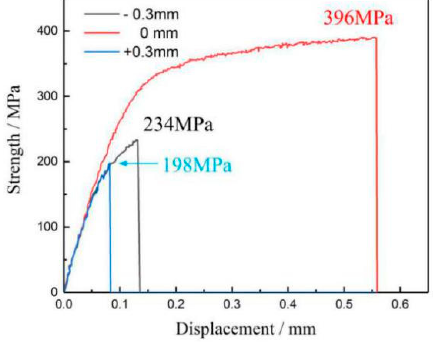
Figure 20. Tensile test results of 301L/Cu/TA2 welded joints.